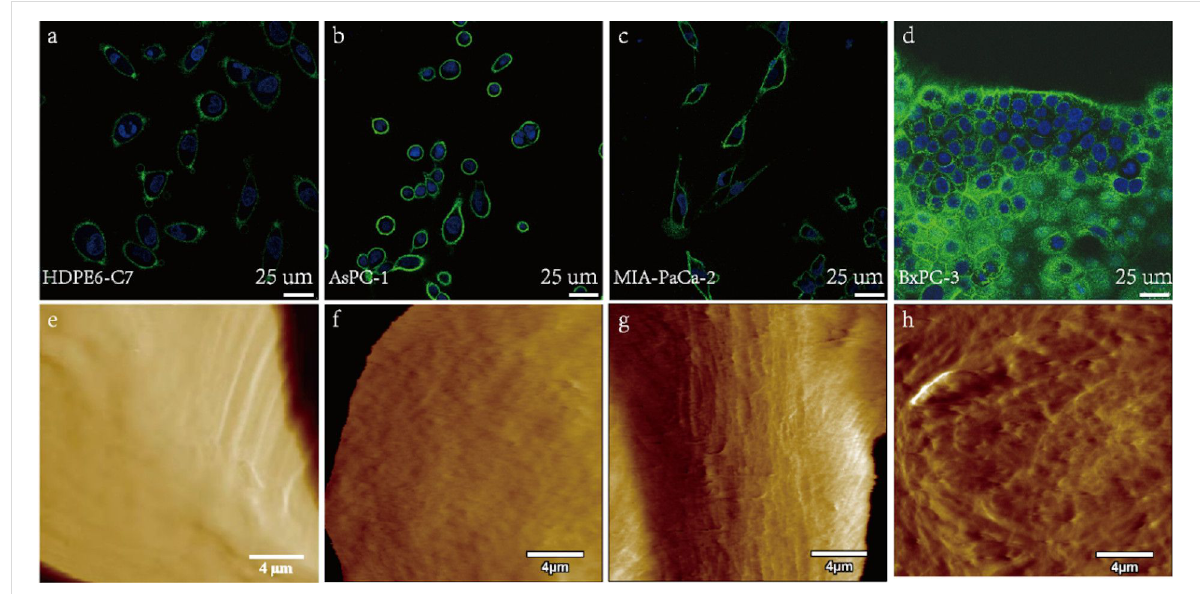
Figure 2: Laser confocal fluorescence images (a–d) and deflection maps (e–h) of (a, e) HDPE6-C7; (b, f) AsPC-1; (c, g) MIA-PaCa-2, and (d, h) BxPC-3.